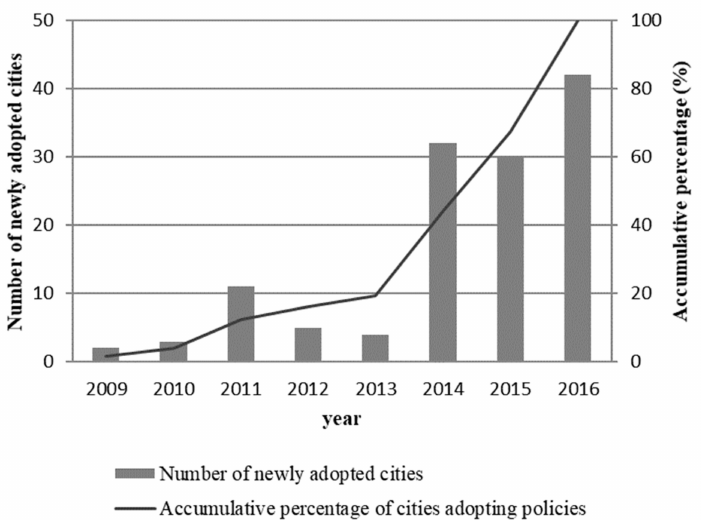
Figure 1. Di ff usion of the financial subsidy policy of new energy vehicles (NEVs) in